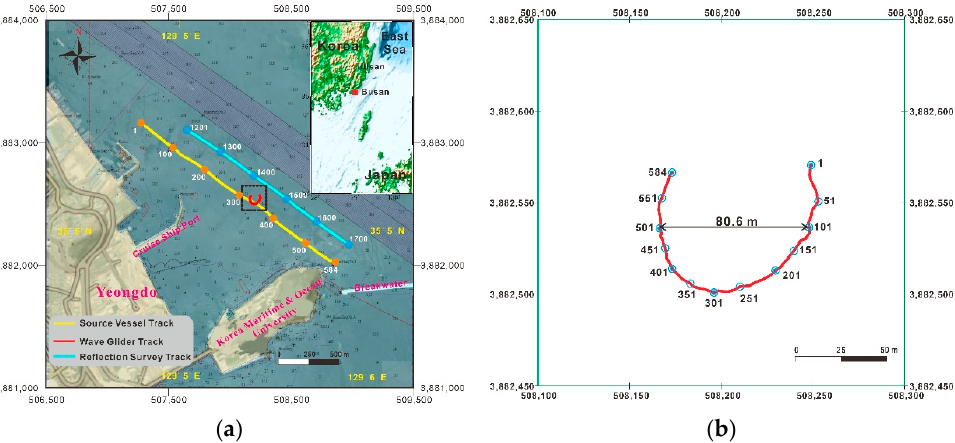
Figure 3. ( a ) Map of the study area marked with the vessel and wave glider survey tracks, and ( b ) subset of a survey track enlarged from the green dotted rectangle in ( a ): the circles indicate every 50 shot points.